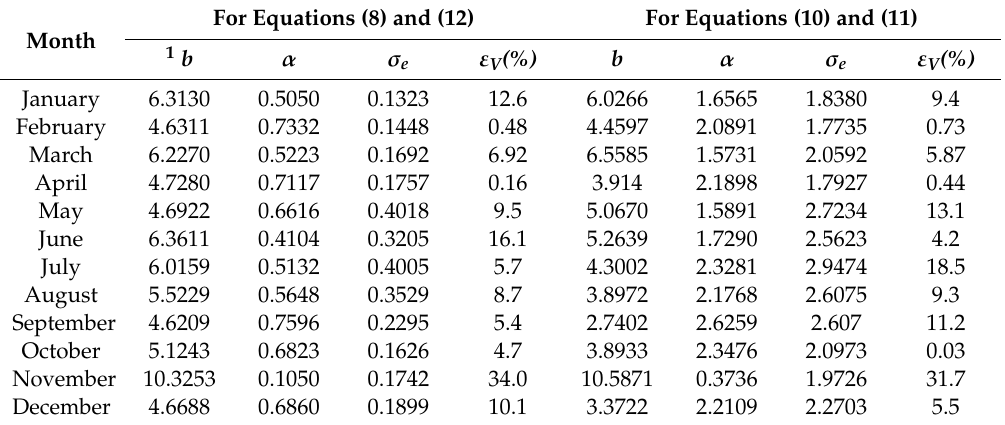
Table 1. Fitted parameters of regression analysis for buoy 42,001 in this study considering seasonality. For Equations (8) and (12) For Equations (10) and (11) Month ε 1 b α σ e V (%) b